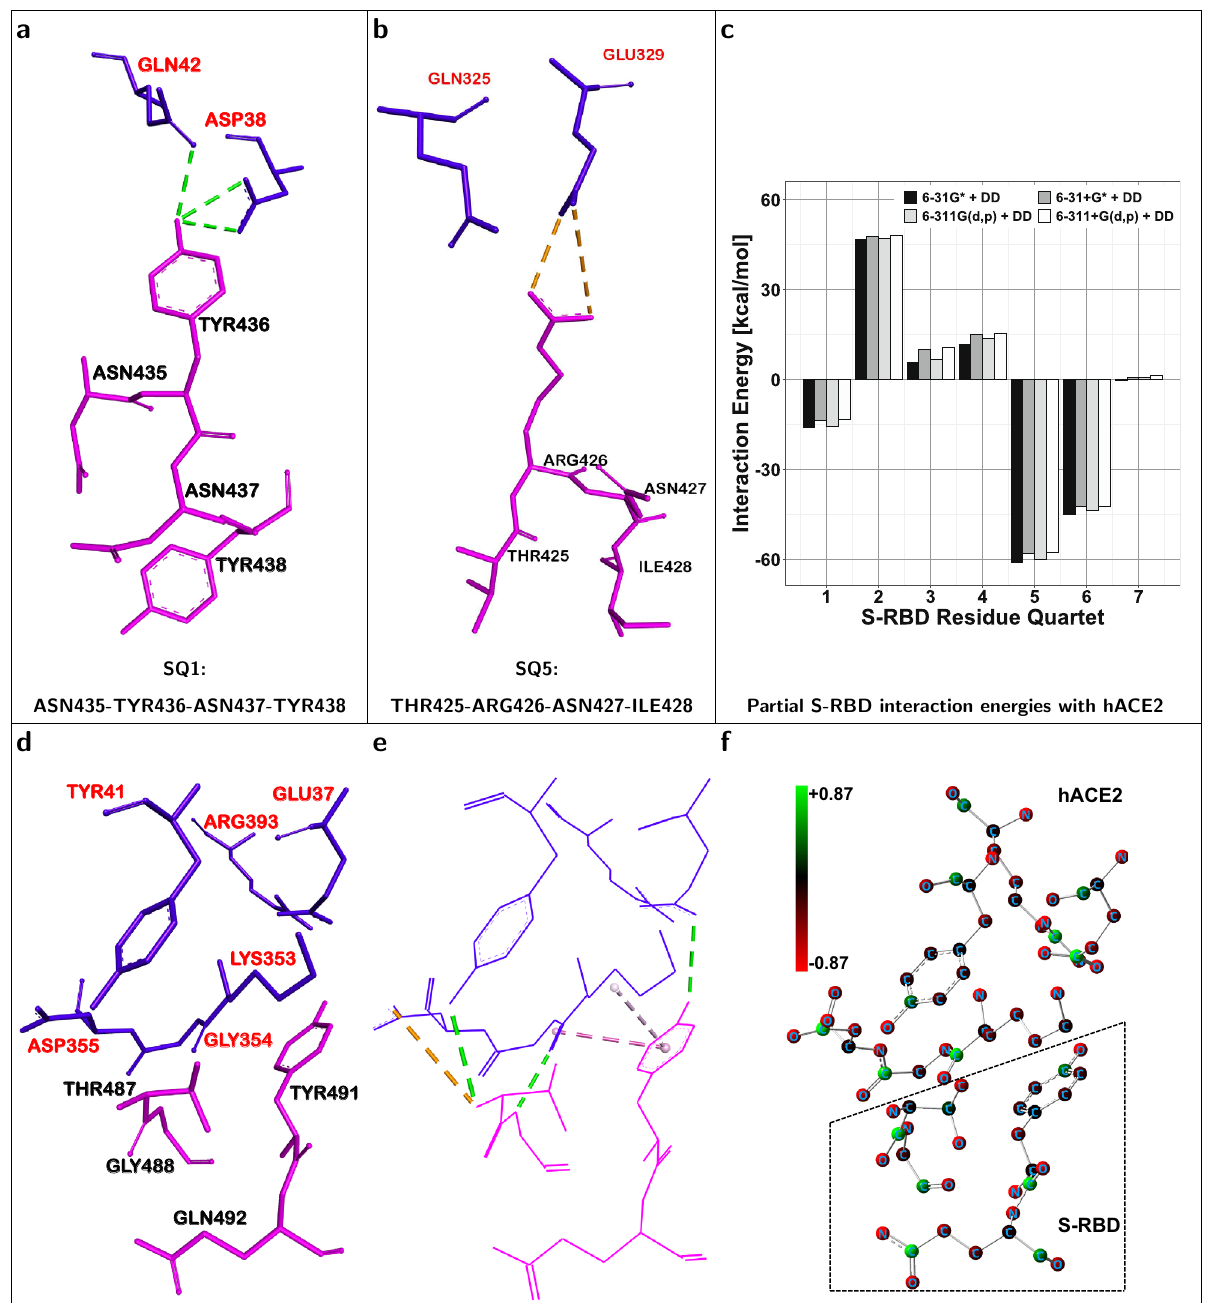
Figure 5. The three S-RBD-centered fragments producing a net attractive interaction towards hACE2. ( a, b ) S-RBD quartet residues (shown in pink) and neighboring ACE2 residues (shown in blue) corresponding to attractive ACE2...S-RBD interactions. S-RBD is the structural reference. ( c ) Main repulsive (positive) and attractive (negative) interactions [kcal/mol] between quartets of the SARS-CoV-1 S-RBD, used as structural references, and neighboring residues of the human hACE2 receptor. The four adjacent vertical bars for each quartet correspond, from left to right, to dispersion -corrected [DD] 27 interaction energies evaluated with the 6-31G*, 6-31+G*, 6-311G(d,p) and 6-311+G(d,p) basis sets. ( d, e ) Constituent residues and selected intermolecular interactions, respectively, of attractive SQ6 -centered fragment. Dotted lines correspond to i) amid- π interactions (dotted pink lines), ii) conventional hydrogen bonds (dotted green lines) and iii) electrostatic interactions (dotted yellow lines). ( f ) Corresponding atoms with positive (green spheres) or negative (red spheres) partial charge. Positively charged hydrogen atoms not shown. Charges evaluated with NBO 33